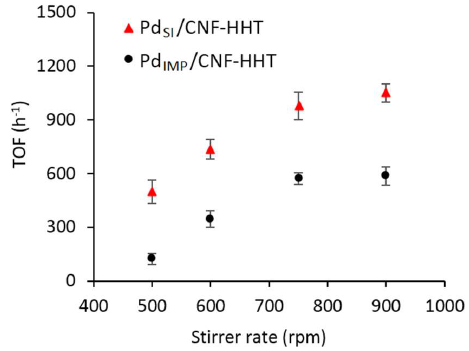
Figure 7. Effect of stirrer rate on TOF. Reaction conditions: 26.5 mg of catalyst (Substrate/metal molar ratio: 2000:1), 30 °C, 0.5 M HCOOH, and 2nd h reaction time.